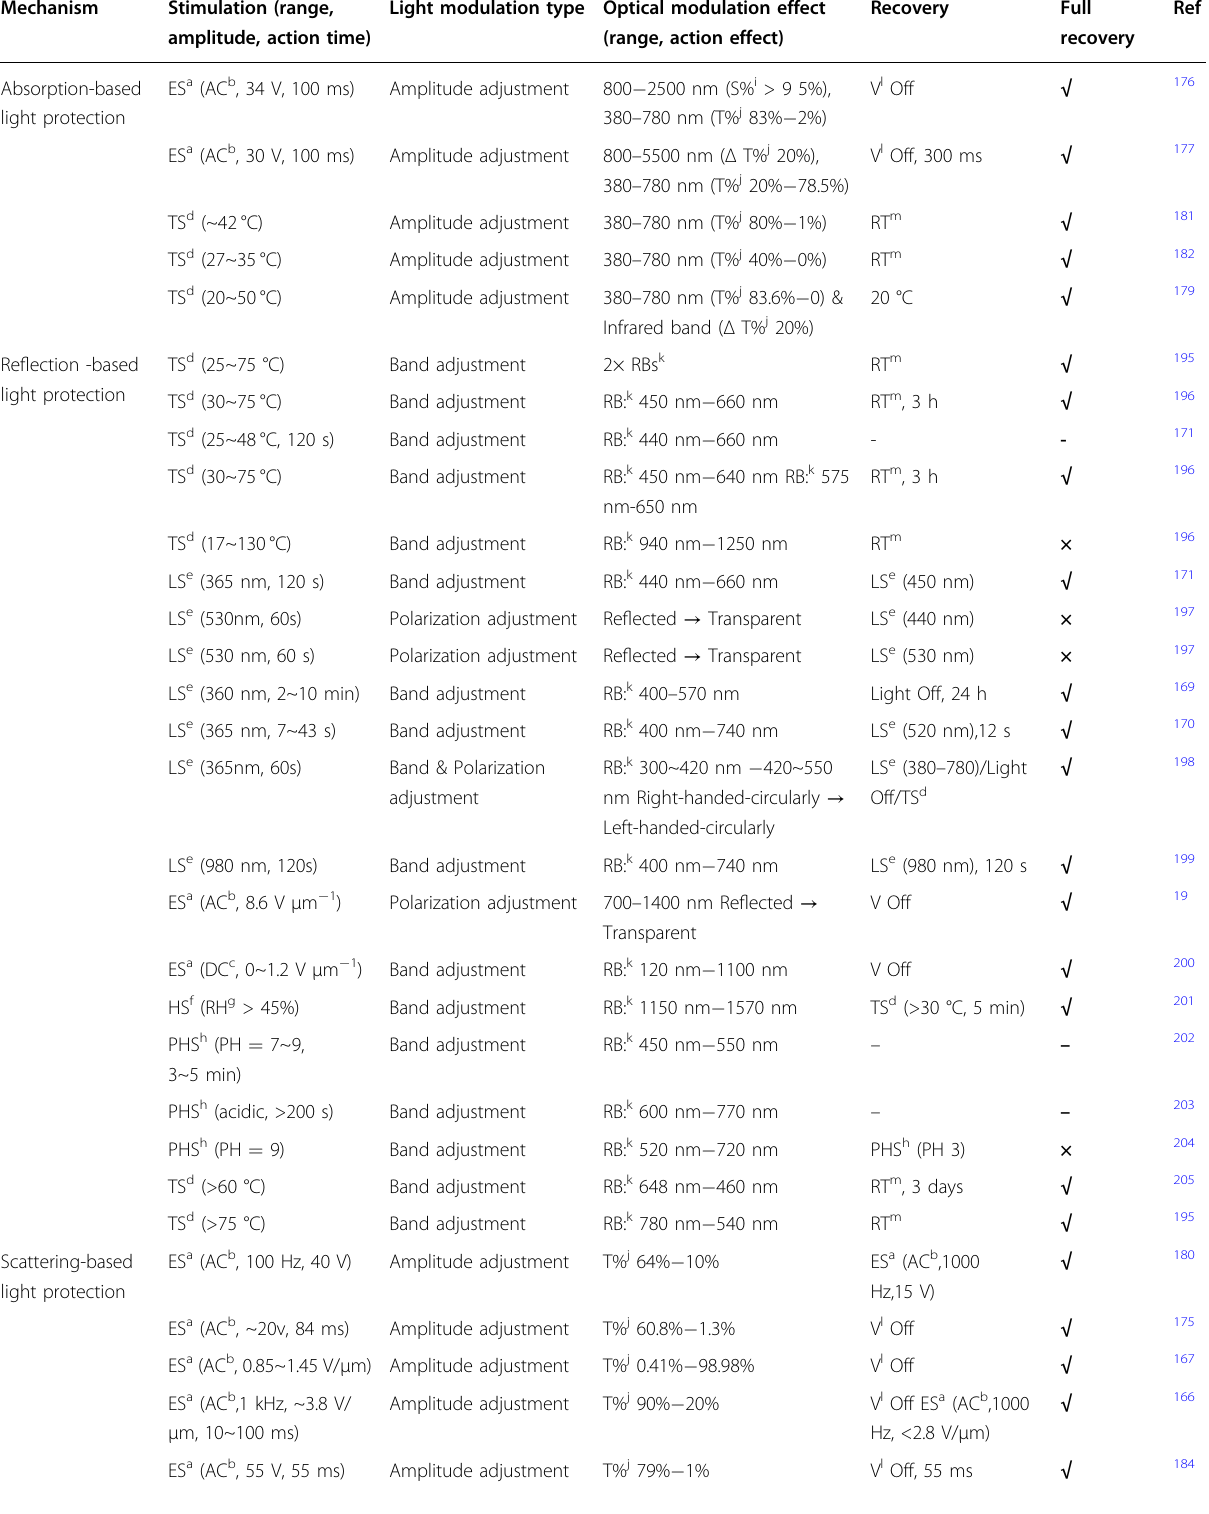
Table 2 Categories of light protection mechanisms based on LCs Mechanism Stimulation (range,